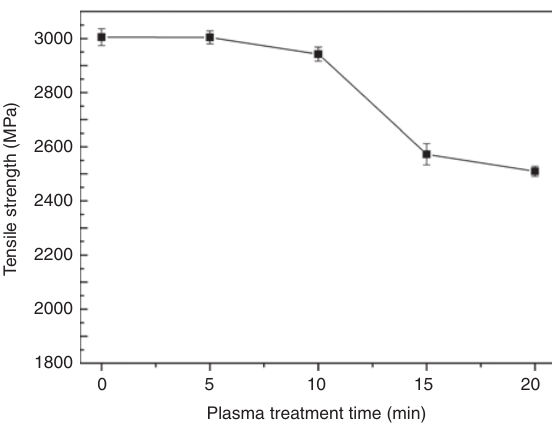
Figure 2: The SEM images of PI fiber under different treatment time: (A) untreated; (B) 5 min; (C) 10 min; (D) 15 min; (E) 20 min.